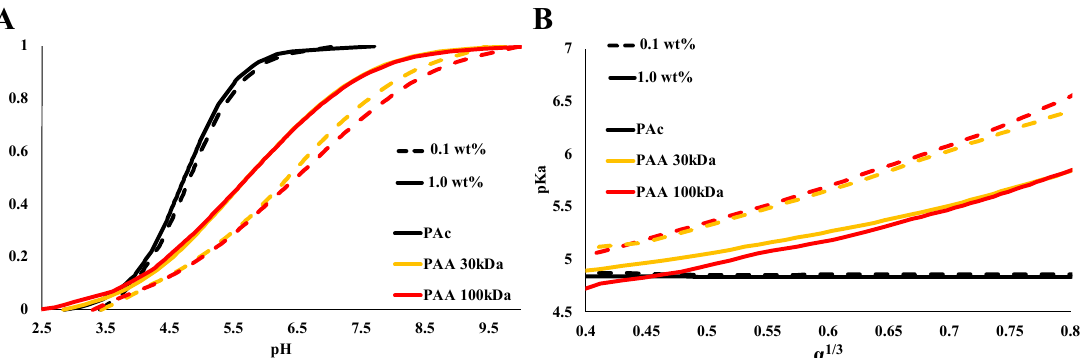
Figure 1. ( A ) Titration curves presenting the degree of ionization ( α ) as a function of pH . PAc, PAA 30 kDa, and PAA 100 kDa ( B ) 𝑝𝐾 (cid:3028) as a function of 𝛼 1/3 . For PAA 0.1 (dashed) and 1 wt% (solid).